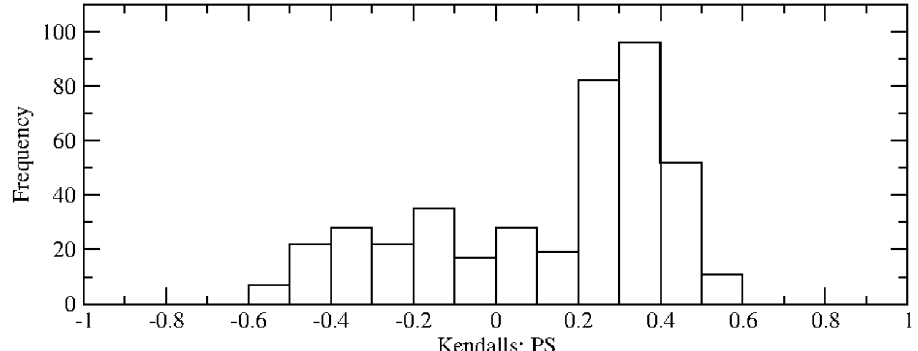
Fig. 3. Histogram of the frequency distribution of the Kendall trend statistic for the PS indicator for the univariate case, for the different windows across the indicator.